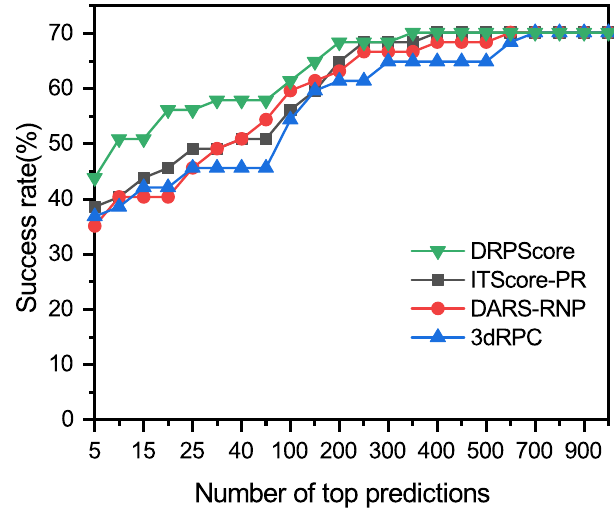
Fig. 1 | The performance of DRPScore and other scoring functions on the bound-bound testing sets. The average success rates and standard deviations (number=3 independent tests) of DRPScore (green inverted triangle), ITScore-PR (black square), DARS-RNP (red circle), and 3dRPC (blue triangle) on the bound- bound testing sets. Data are presented as mean values+/- SD. Source data are provided as a Source Data fi le.